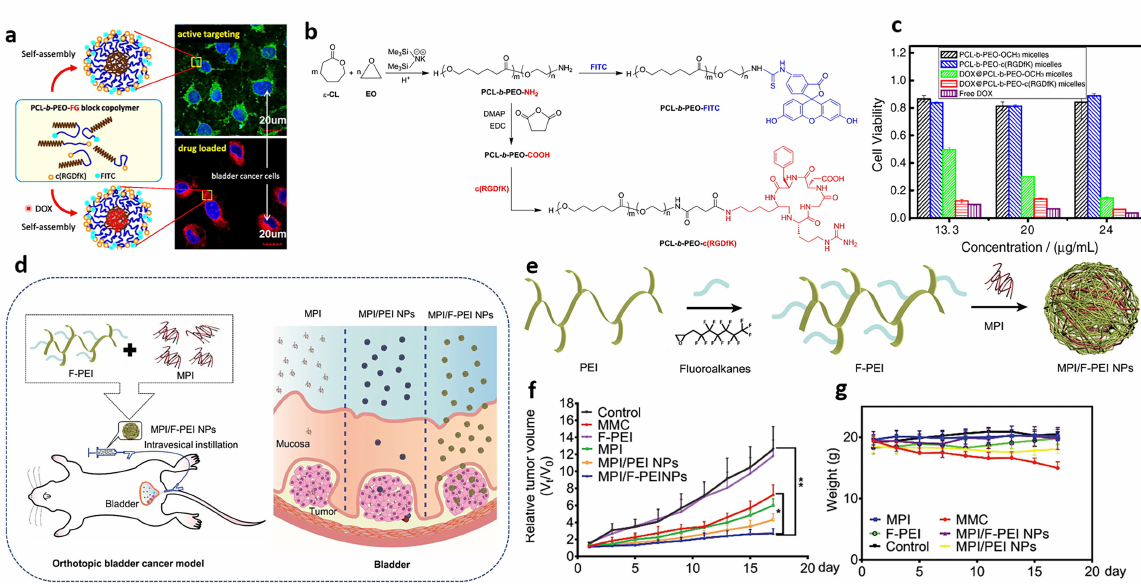
Figure 10. ( a ) Schematic illustration of the c(RGDfK) decorated polymeric micellar drug delivery sys- tem, which was developed for intravesical chemotherapy for superficial bladder cancer. ( b ) Synthesis of PCL-b-PEO-NH2 block copolymers and the conjugation with RGD and FITC. ( c ) Cell viability of T24 cells after incubation for 72 h with various DOX formulations in different